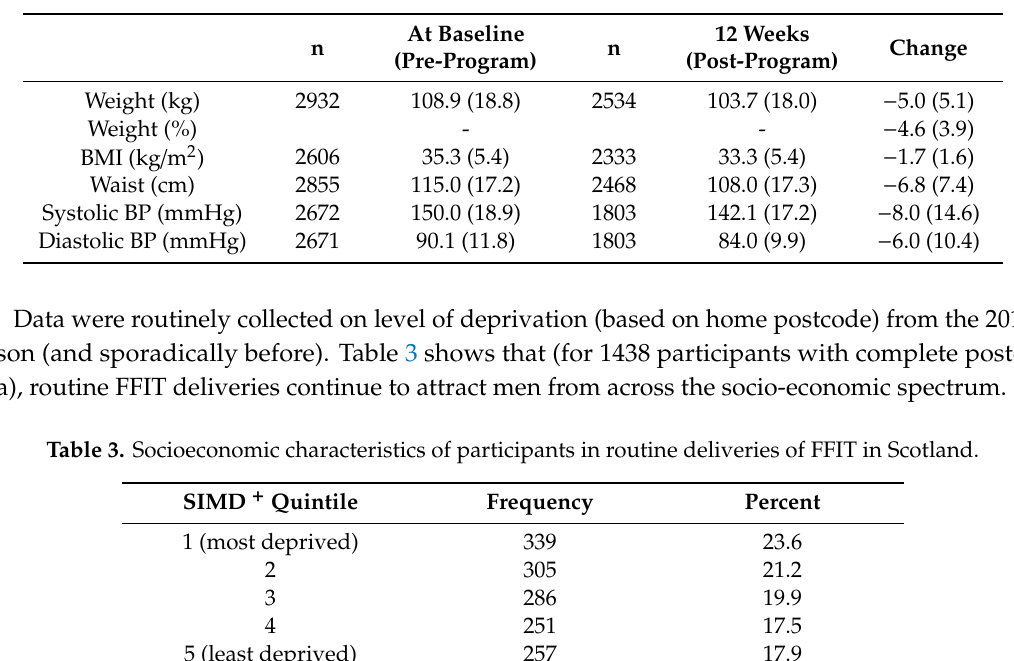
Table 2. Physical measures at start (baseline) and end (post-program) of routine deliveries of FFIT in Scotland (mean [SD]) (n = 2940 / 3320 men who had no missing data on age).